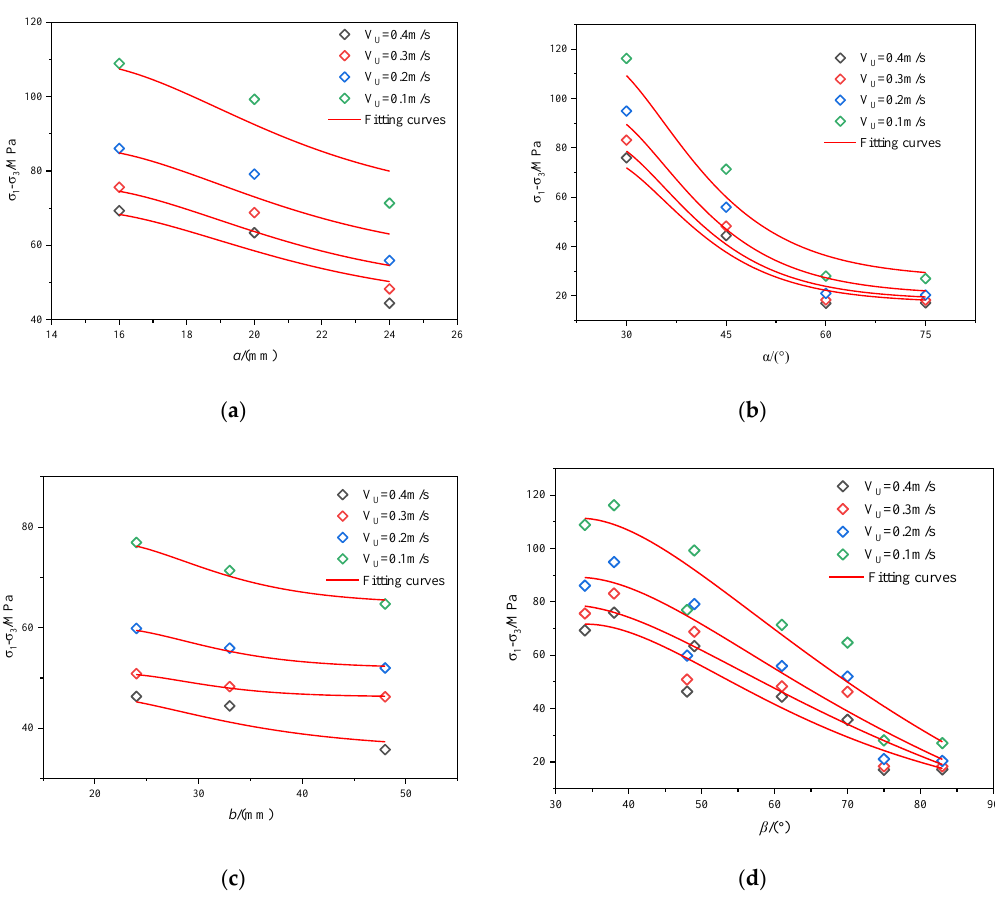
Figure 13. Influences of ( a ) crack length, ( b ) crack inclination angle, ( c ) ligament length, and ( d ) ligament inclination angle on the numerically predicted peak values of axial deviatoric stresses.